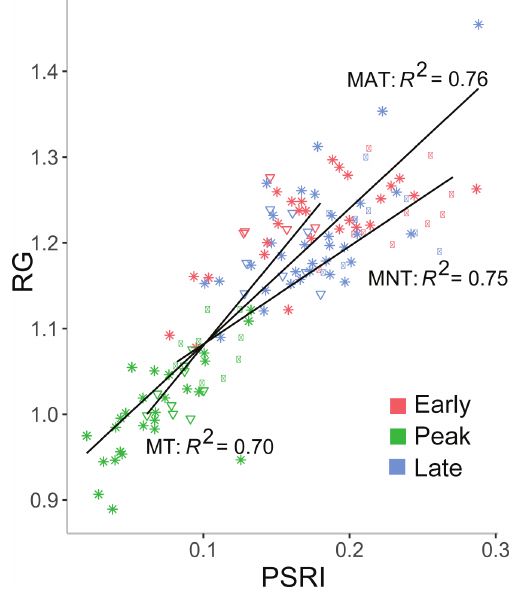
Figure 17. The relationships between pigment-driven spectral in- dices of the plant senescence reflectance index (PSRI) calculated from canopy-level spectral reflectance and the simple normalized red–green index calculated from digital camera data in three domi- nant vegetation communities. MNT: moist nonacidic tundra; MAT: moist acidic tundra; MT: moss tundra. PSRI is used to track plant senescence related to the degradation of chlorophyll pigments (Beamish et al., 2018).